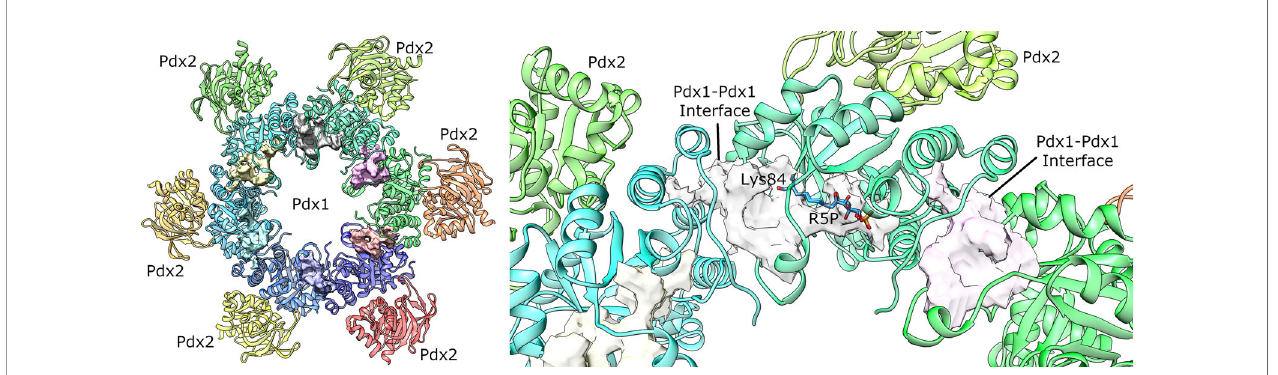
FIGURE 5 | Pockets mapped on Plasmodial PLP synthase complex by DoGSiteScorer (Volkamer et al., 2012b). The larger identi fi ed pockets are shown as surfaces. (left) Overall view of the PLP synthase complex. The second Pdx1 hexamer and attached Pdx2 enzymes was omitted for clarity. (right) Detailed view of the best ranked pocket. For the sake of comparison, the substrate bound to the catalytic lysine 84 is also shown (manually docked from the A. thaliana crystal structure, PDB ID 5LNS). The surface in this site includes the substrate binding pocket and is also extended to the surface where the enzyme interacts with the partner shown in cyan ribbon. Similar pockets are also identi fi ed for the other monomers, as shown in pink and yellow transparent